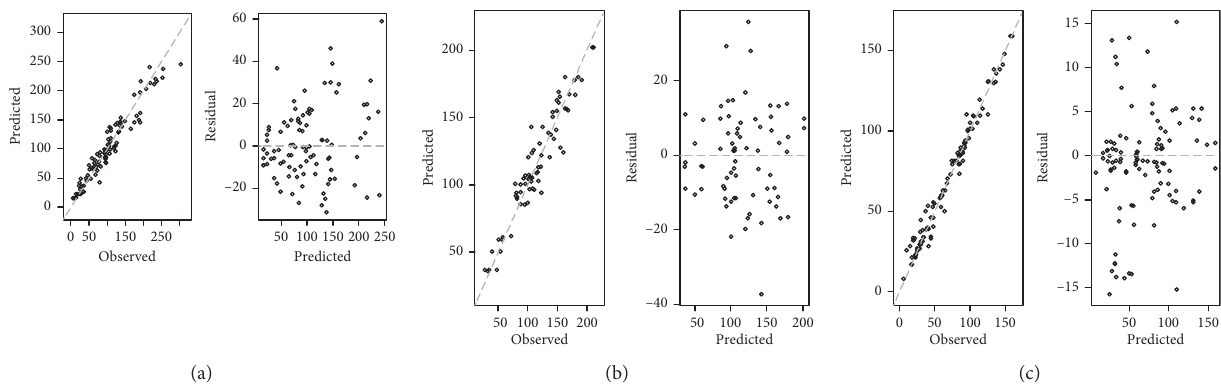
Figure 2: Left: predicted versus observed CS values for rock datasets; right: residuals versus the predicted values. (a) Dataset 4. (b) Dataset 5. (c) Dataset